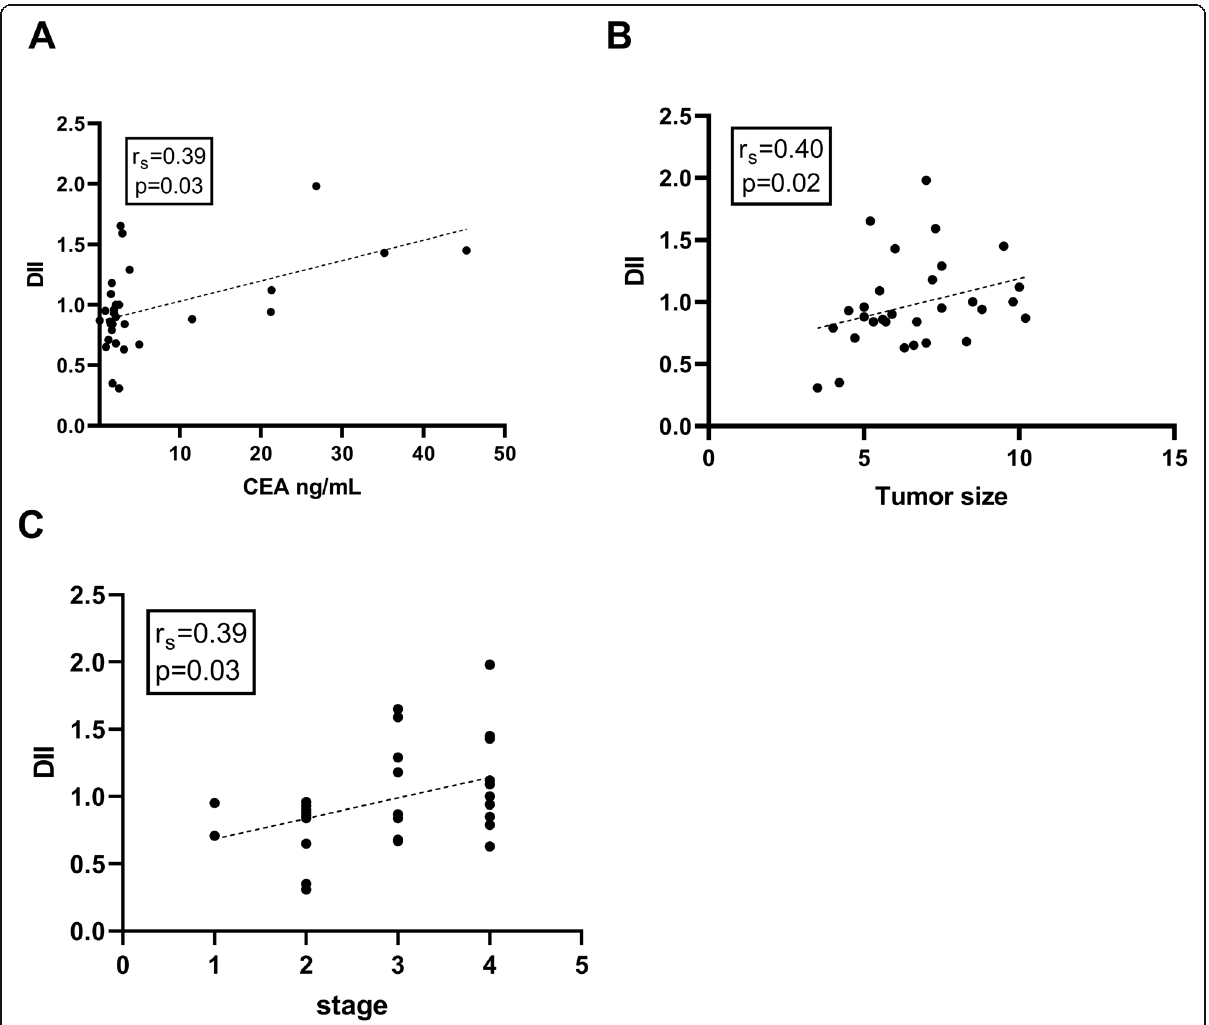
Fig. 4 DII in CRC patients correlated with CEA ( a ), tumor size ( b ), and tumor stage ( c